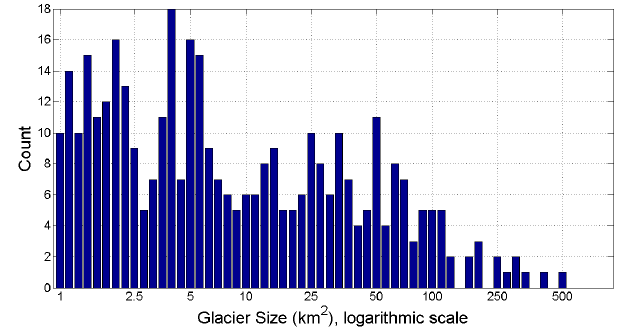
Figure 4. Glacier size class distribution ( n = 750) for the manual control data set. Note the logarithmic x axis to account for a wide range of glacier sizes.